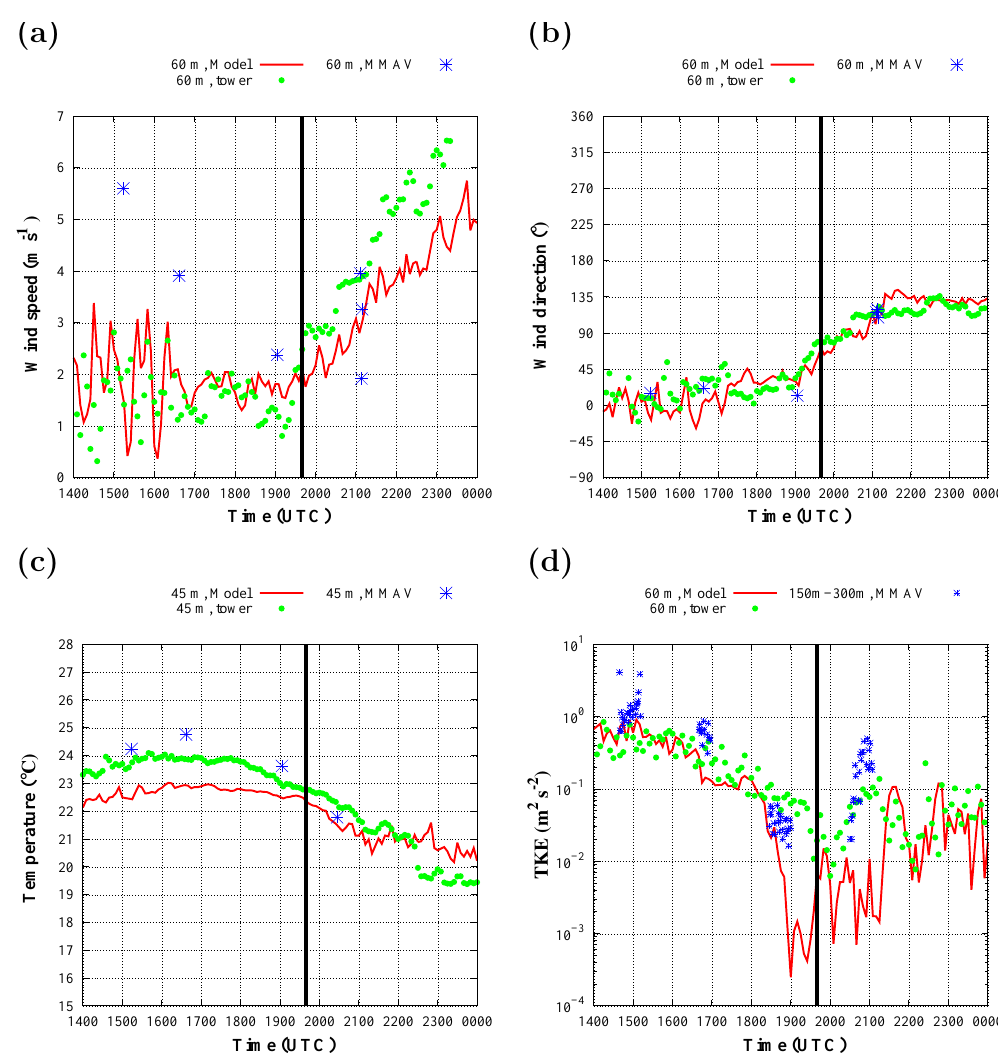
Figure 3. Modelled and observed time series for (a) wind speed (in ms − 1 ), (b) wind direction (in ◦ ), (c) temperature (in ◦ C) and (d) TKE (in m 2 s − 2 ) from 14:00UTC until midnight on 2 July 2011. Tower observations are in green circles, model results in red lines and M 2 AV data in blue asterisks. The temporal evolution of wind and temperature data from M 2 AV is constructed with the values of the vertical profiles taken at the corresponding height of the tower measurements. For TKE, all the M 2 AV legs where TKE is derived, at 150, 200, 250 and 300ma.g.l., are included in the plot. The time of sunset is represented by a black vertical